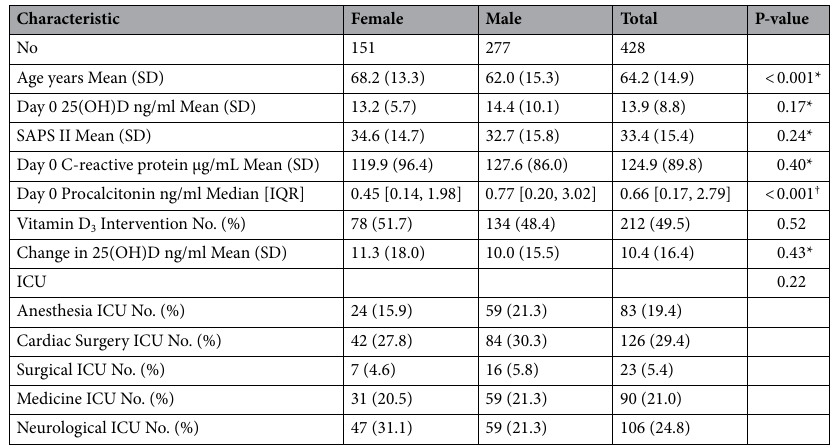
Table 1. Cohort characteristics. Data presented as No. (%) unless otherwise indicated. P -values determined by chi-square unless designated by (*) then P -value determined by ANOVA or by ( † ) determined by Kruskal– Wallis